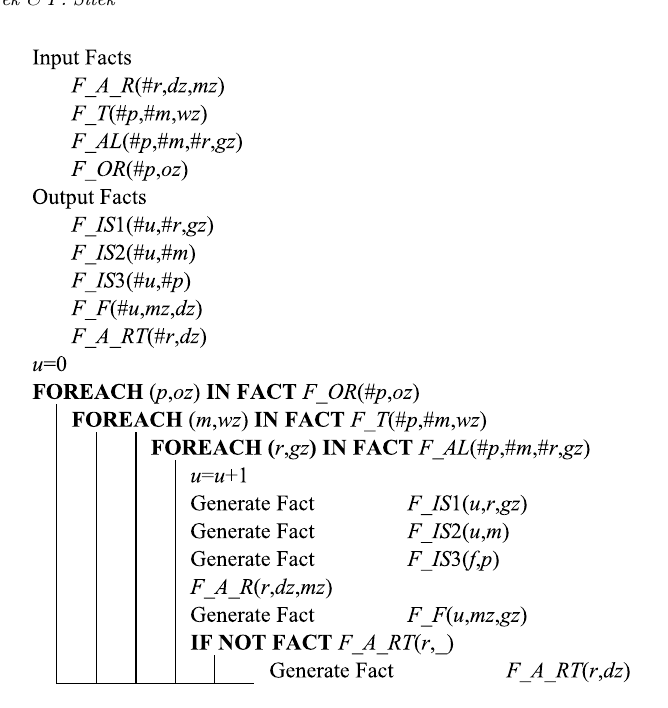
Fig. 4. The procedure for transformation of